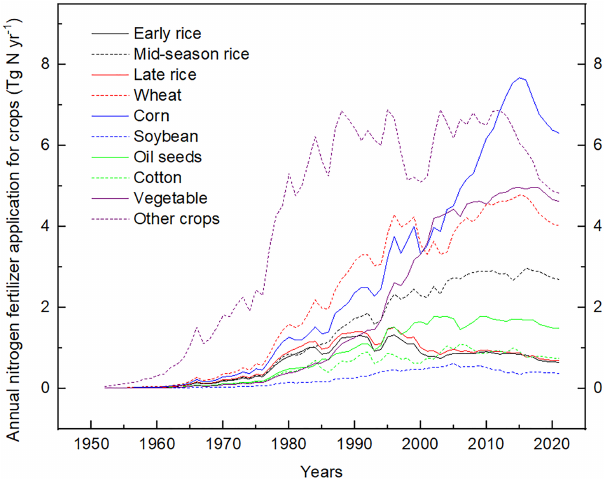
Figure 3. Nitrogen fertilizer use in major crop types from 1952 to 2018 (gNm − 2 yr − 1 ).